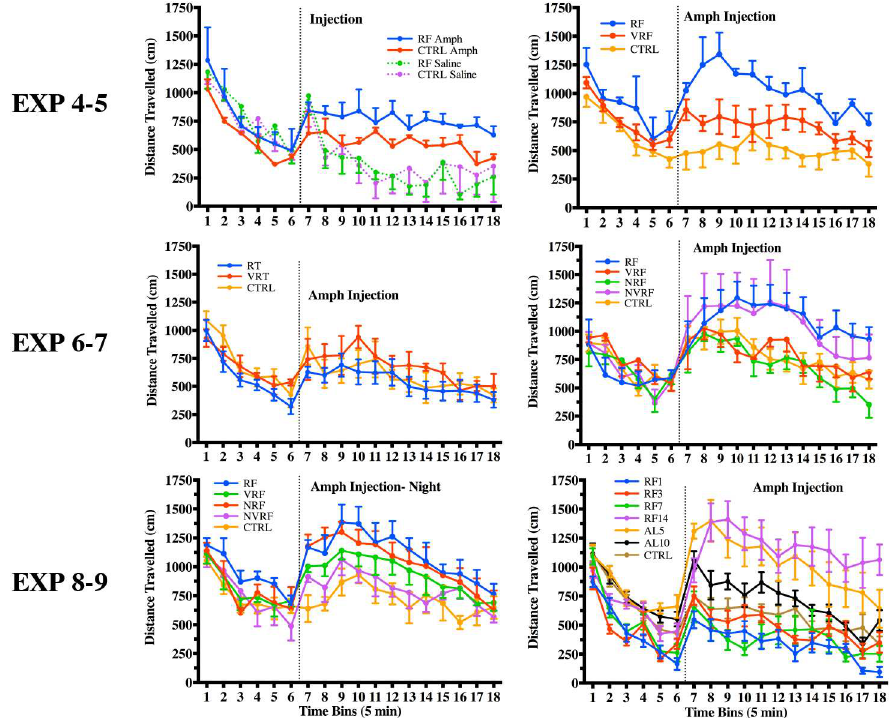
Fig 7. Feeding schedule cross-sensitization to AMPH test. Distance travelled to an acute injectionof AMPH, plotted in 5-min time bins +/- SEM for feedinggroups in experiments 4–9, respectively.Dotted line